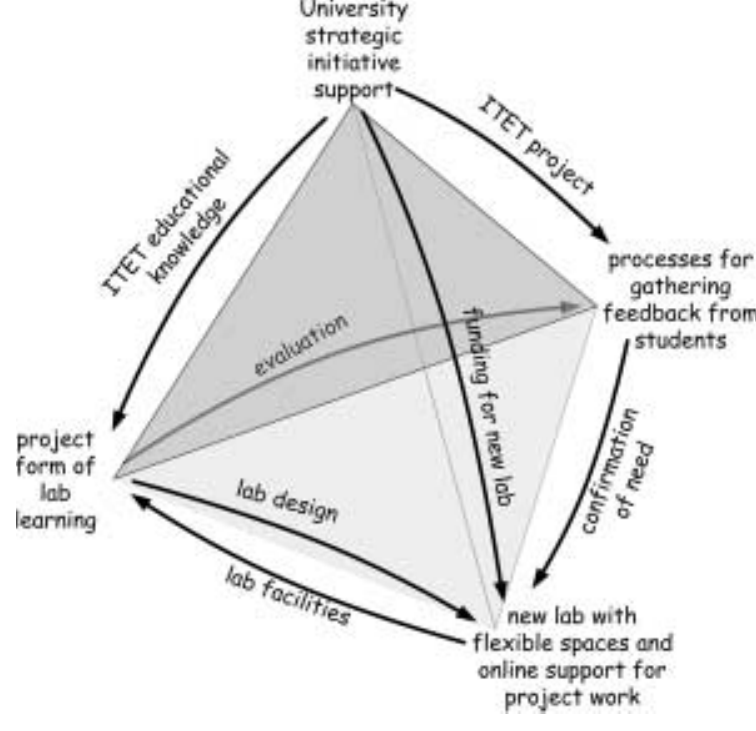
Figure 3. Changes in the UNSW School of